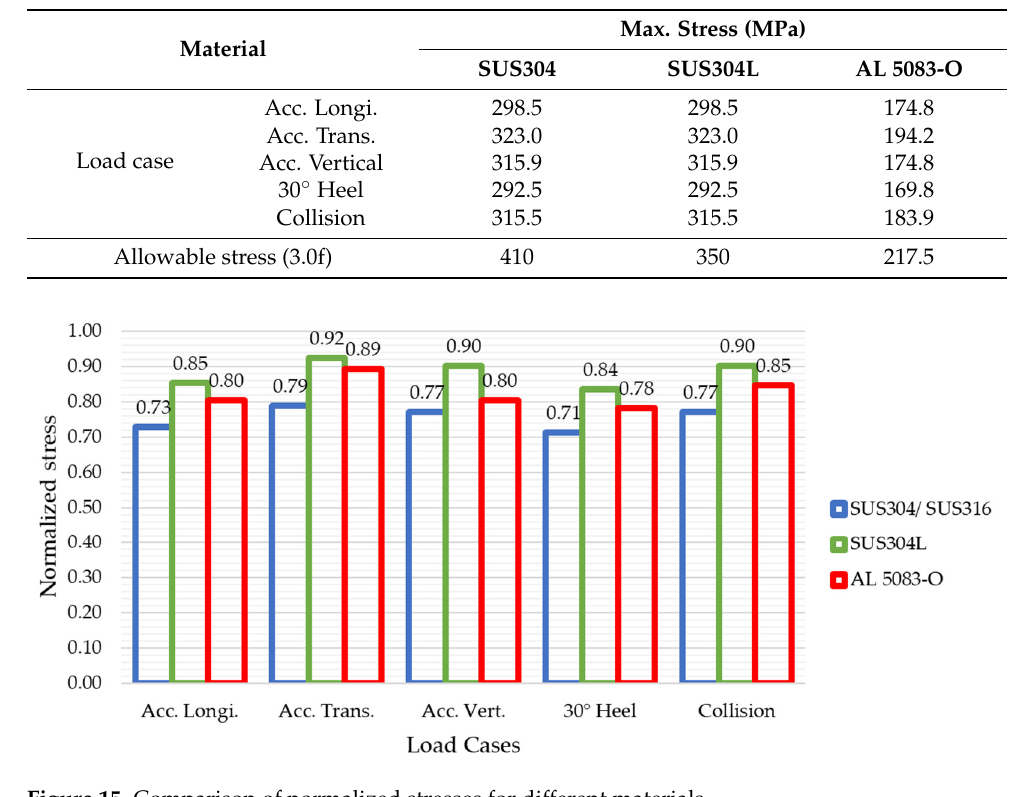
Figure 14. Stress contour of strength evaluation in transverse acceleration (AL-5083-O). Table 7. Summary of structural analysis results. Table 7. Summary of structural analysis results.